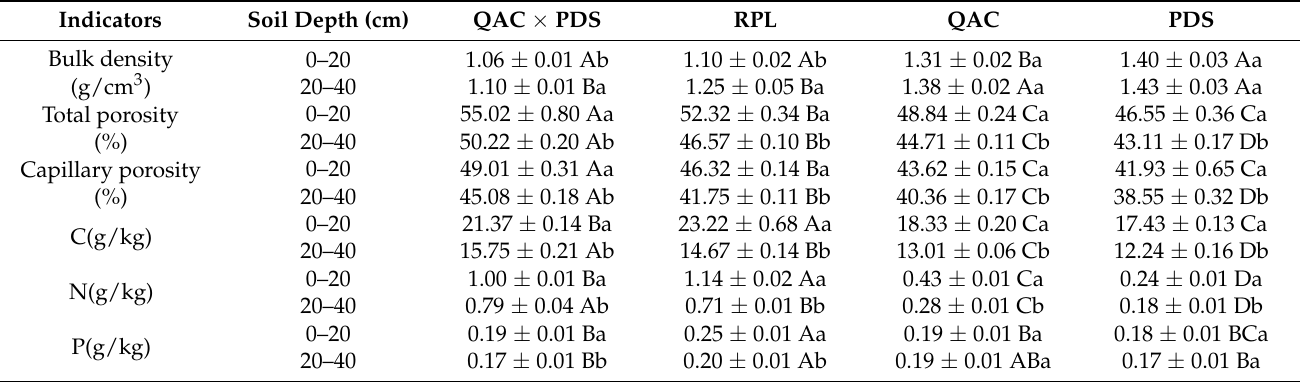
Table 1. Soil physicochemical properties of four vegetation restoration types.